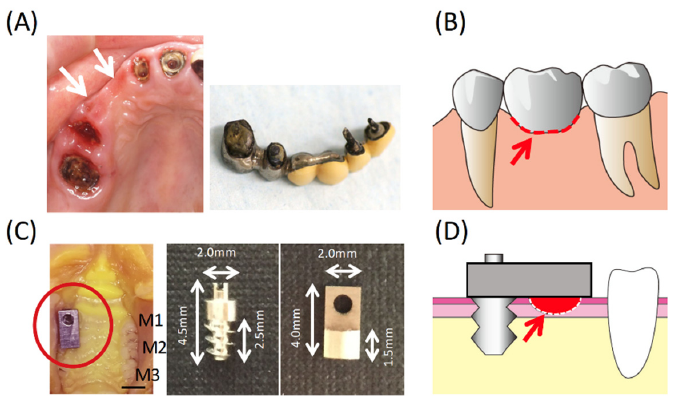
Figure 1. ( A ) The oral mucosa (white arrows) in contact with the bridge pontic base and the detached bridge pontic base. ( B ) Schematic diagram of the bridge area (the red dot and arrow indicate the focus area of this study). ( C ) Photographs of the experimental implants and the implant in the rat oral cavity with no evidence of inflammation. Bar = 2 mm. ( D ) Scheme of the experimental model and the observed area on the base of the bridge pontic.